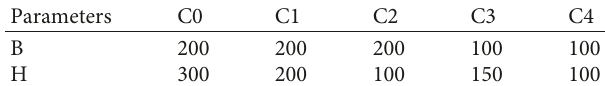
Table 1: Cross-section parameters of timber poles.